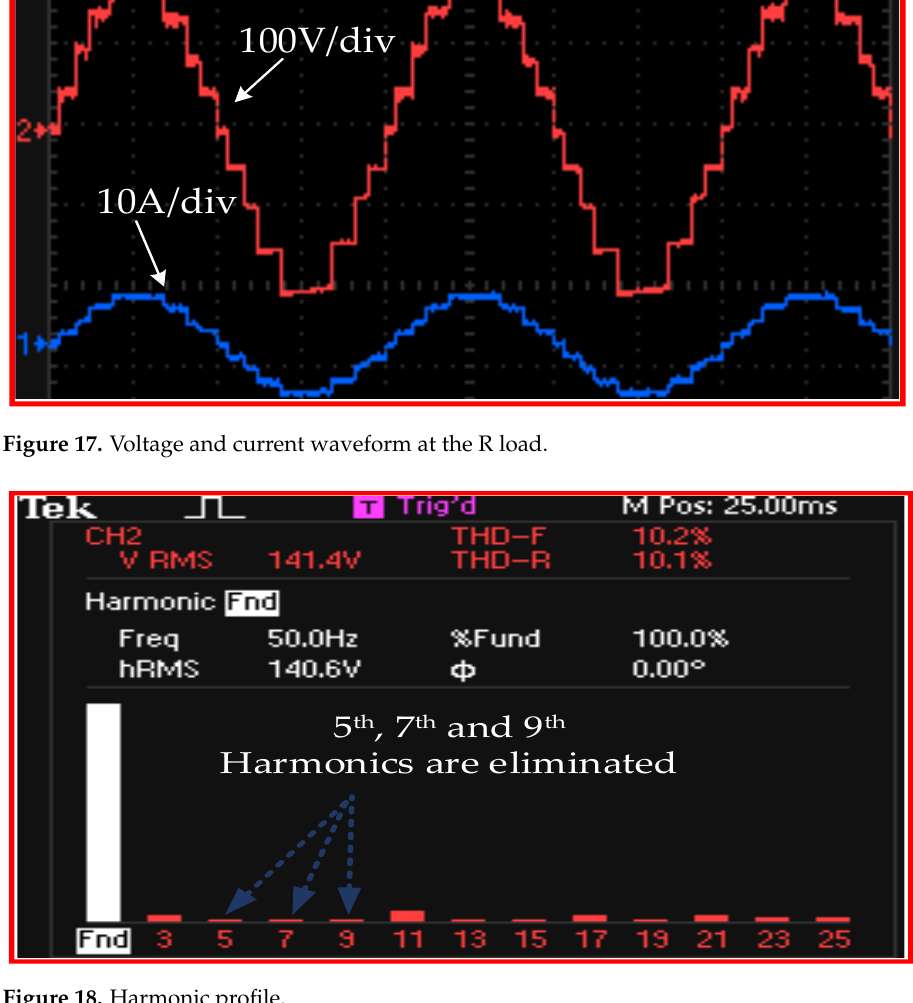
Figure 18. Harmonic profile.